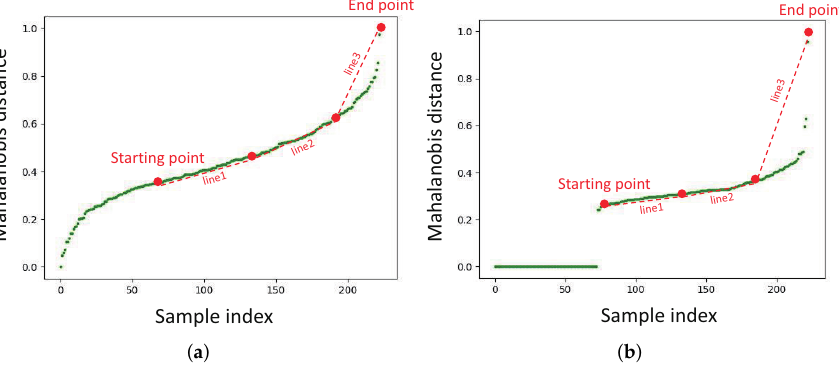
Figure 6. ( a ) The sorted Mahalanobis distance plot for a certain patch in the first iteration. ( b ) The sorted Mahalanobis distance plot of a certain patch at a certain iteration.